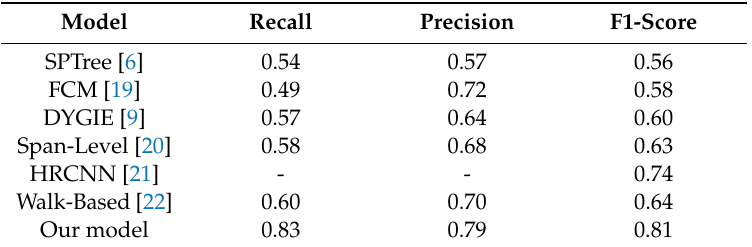
Table 6. Performance comparison on the ACE-2005 corpus.